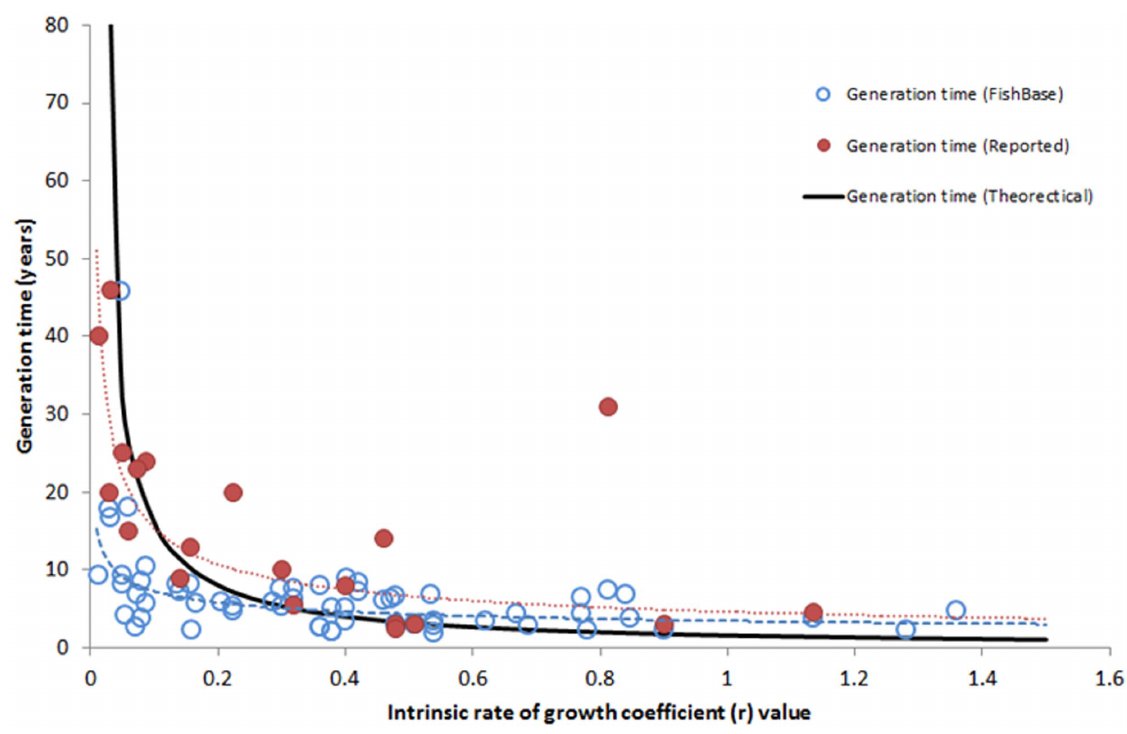
Figure 3. The empirical relationship between intrinsic rate of growth coefficient ( r ) and generation time, for which r values (based on F msy and U msy ) and generation time (based on FishBase and reported values from rebuilding plans) are available. The theoretical relationship between r and generation time ( G ) is provided by the equation G = ln R 0 / r , where R 0 (the net reproductive rate per generation) is assumed to be 5, which is roughly the median value of R 0 for the r and either FishBase or reported generation times.